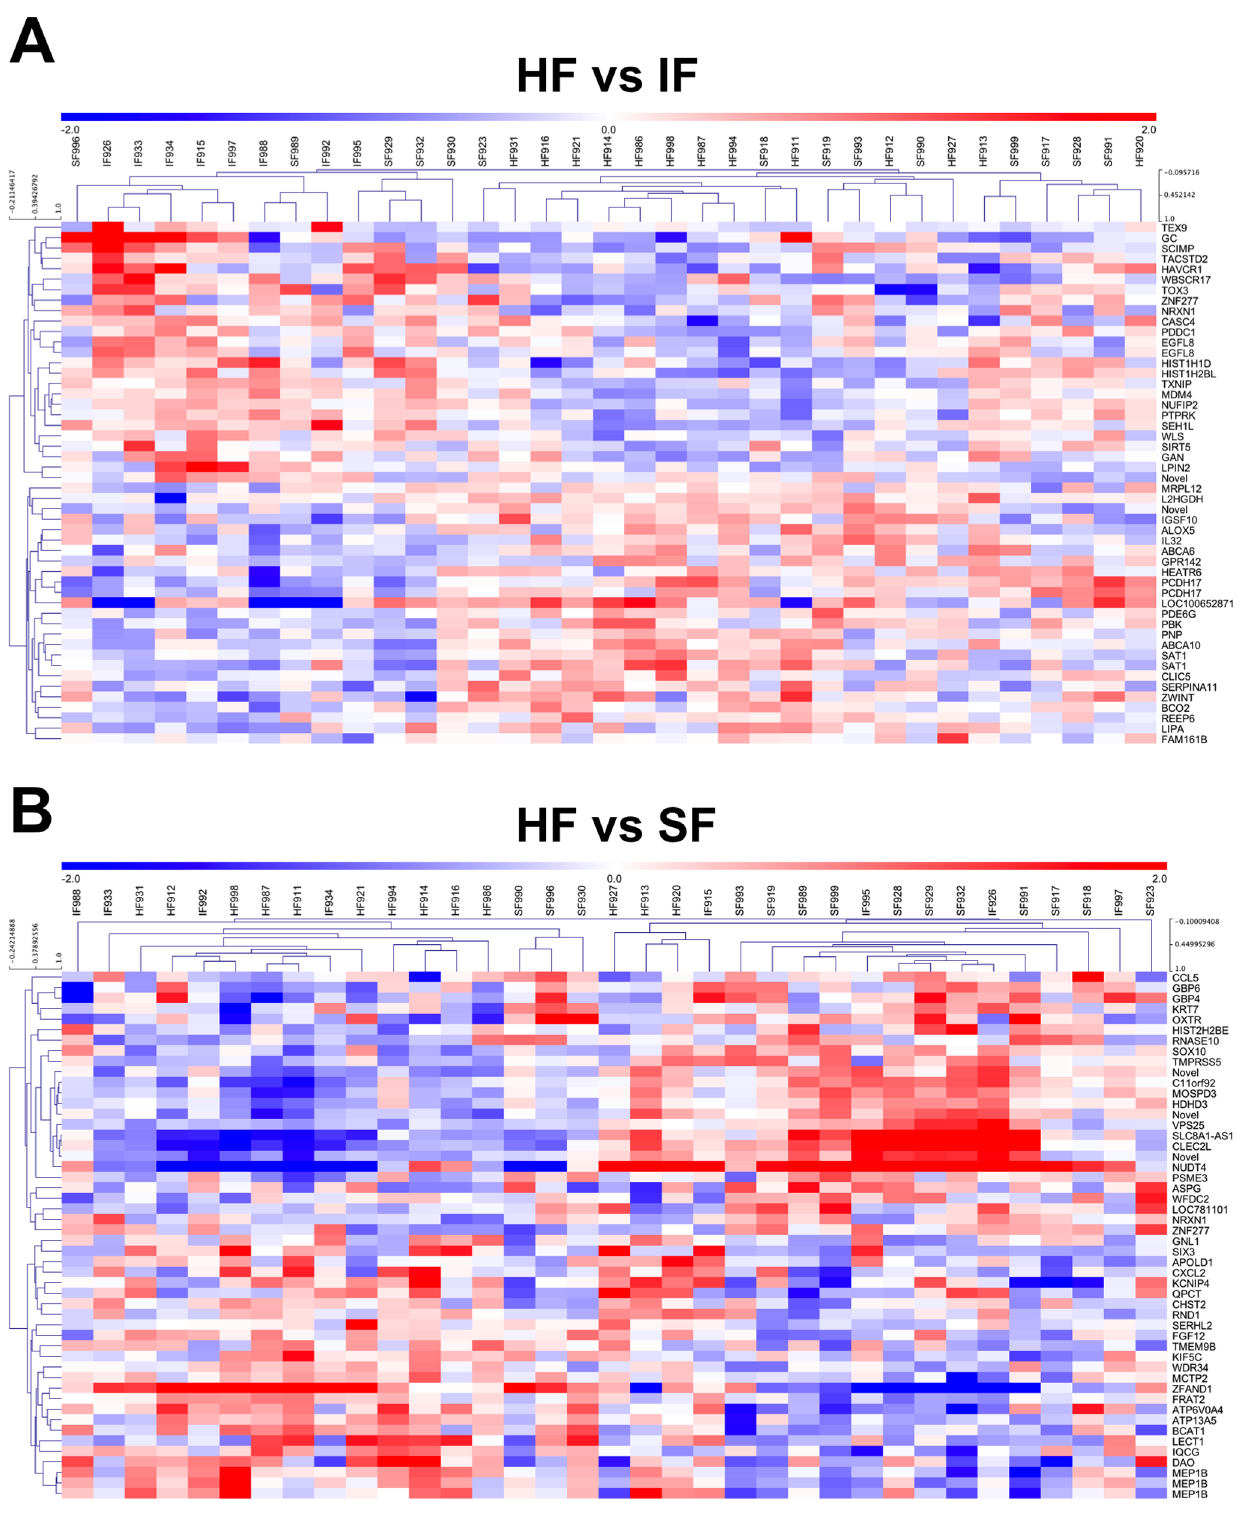
Figure 5. Hierarchical clustering analysis of differentially expressed genes in the endometrium of fertility-classified heifers. Up- regulated (red) and down-regulated (blue) genes are presented.